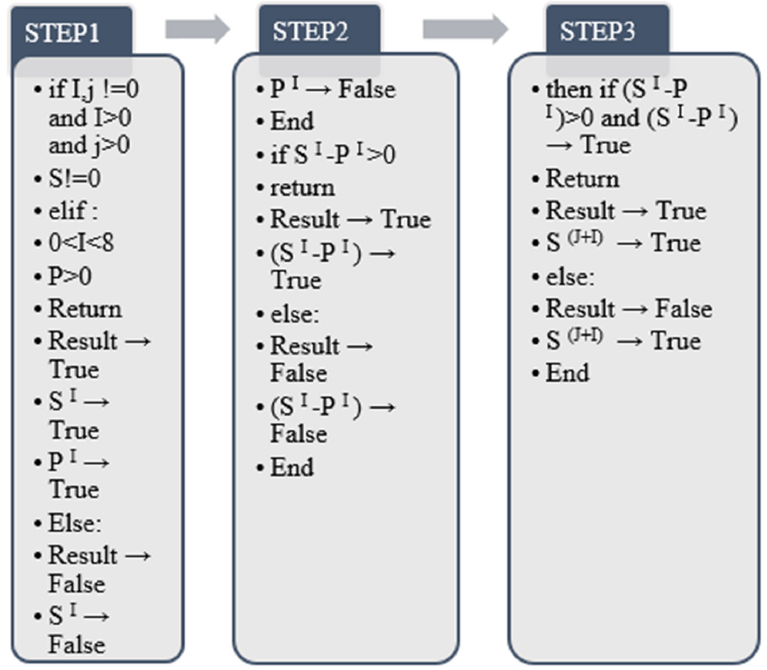
Figure 12. One-dimensional convolution and recursive feature extraction algorithms.